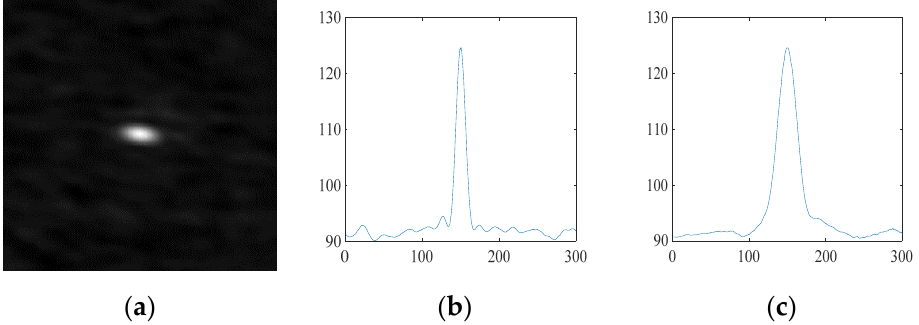
Figure 2. ( a ) Point spread function (PSF) with motion blur; ( b ) projection in the x-z plane; ( c ) projection in the y-z plane.